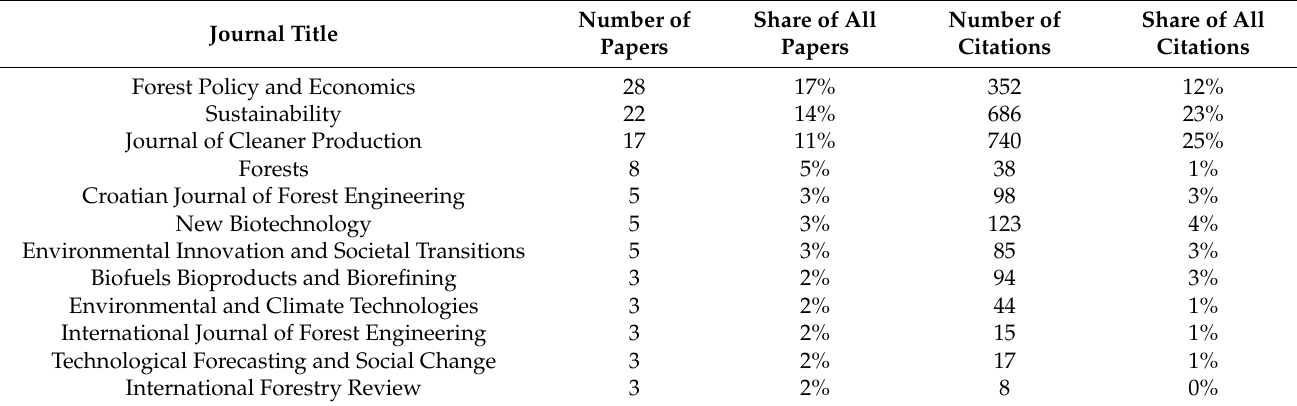
Table 5. Journals with at least three papers